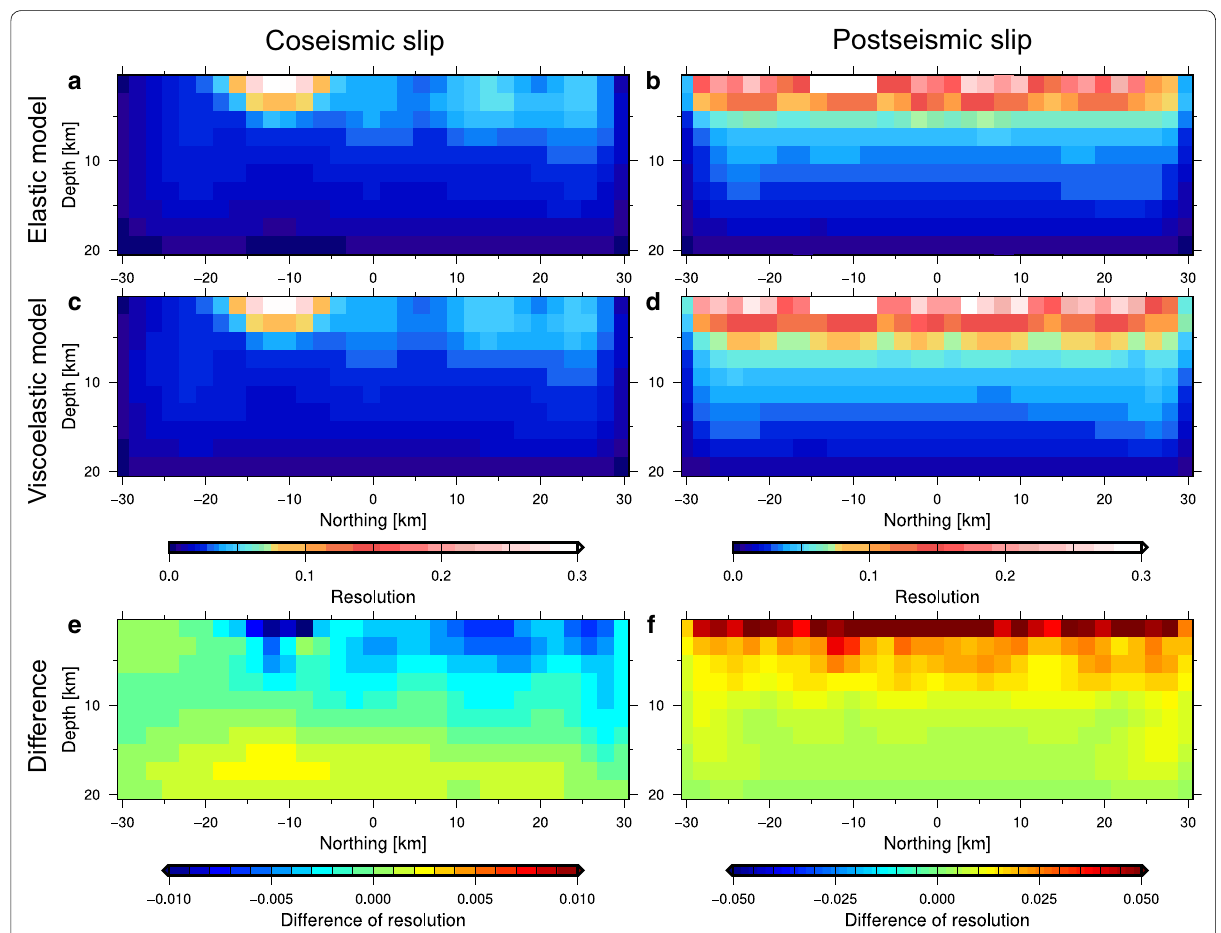
Fig. 4 Resolution for the strike–slip case. a , b The spatial resolution of the co- and post-seismic slip distributions in the elastic model for the strike– slip case, respectively. c , d The spatial resolution of the co- and post-seismic slip distributions in the viscoelastic model for the strike–slip case, respectively. e , f The spatial resolution of the co- and post-seismic slip distributions subtracting that in the elastic model from that in the viscoelastic model,